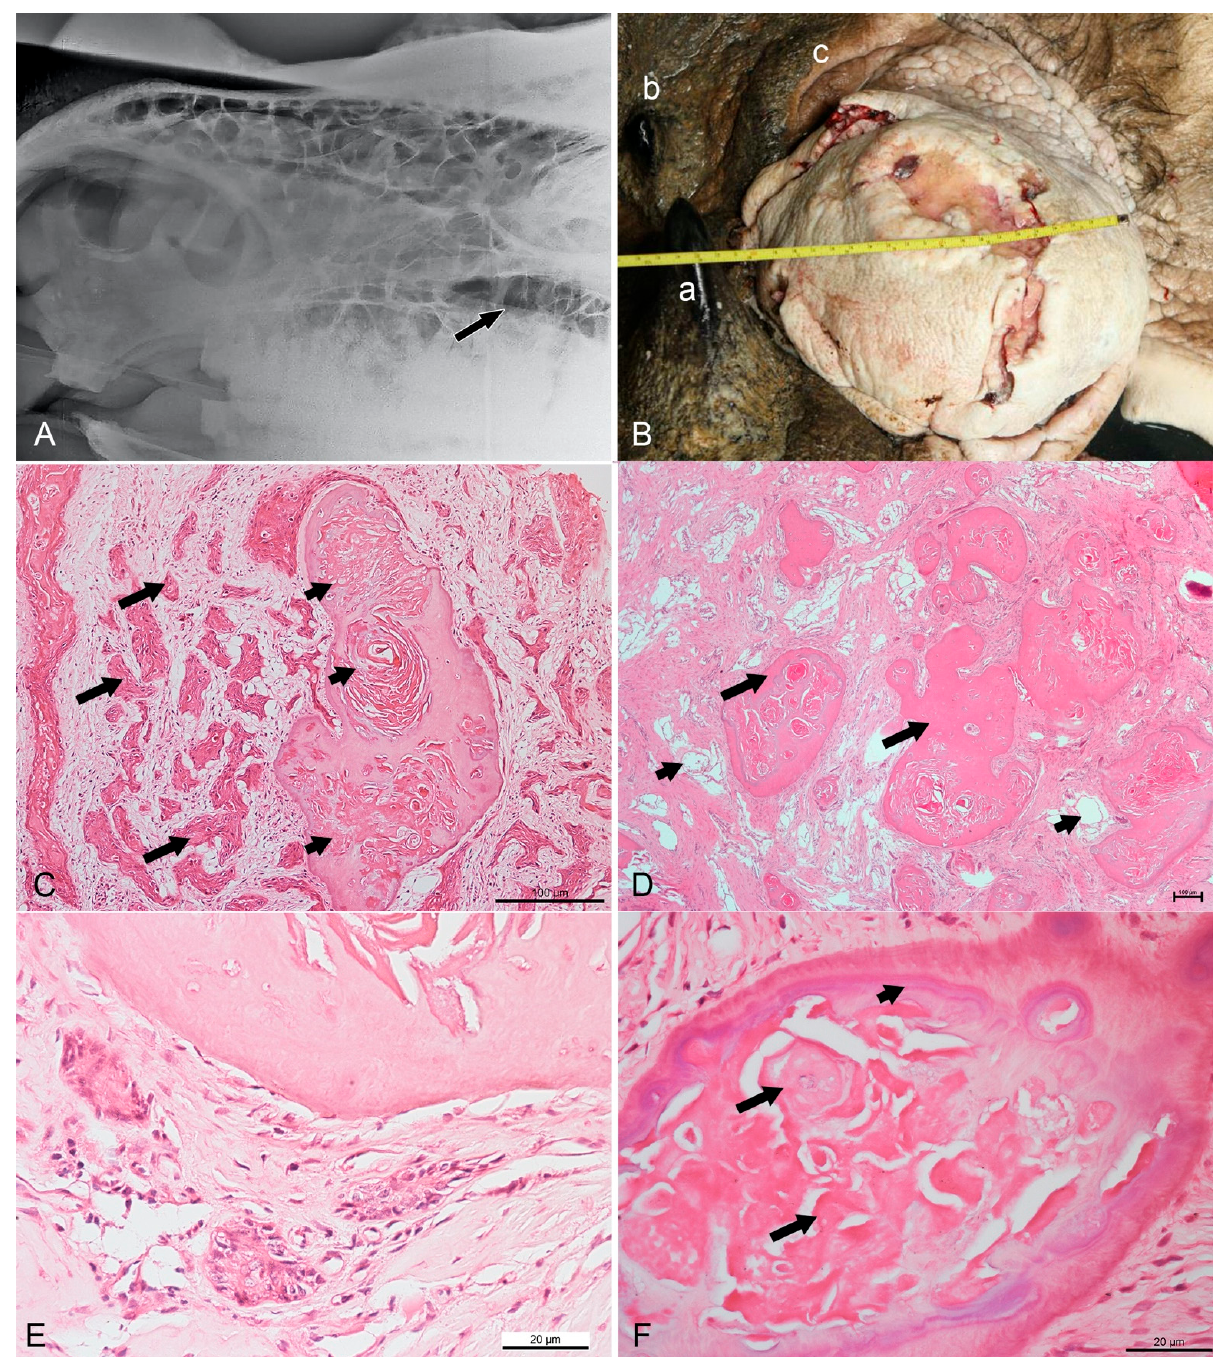
Figure 1. Radiographic, gross, and routine histopathological findings in a Sumatran rhinoceros with a dentinogenic ghost cell tumor. ( A ) Left-lateral view radiograph taken in April 2017 showing a unilocular radiolucent cyst (arrow) at the left maxilla. ( B ) The infraorbital mass in June 2017 measuring 21 cm × 30 cm. a: anterior horn, b: posterior horn, c: left upper eyelid. ( C ) Nests of neoplastic squamous cells (long arrows) surrounded by substantial compact fibrous stroma. Note the formation of keratin pearls (short arrows) embedded in a dentinoid material. HE (hematoxylin and eosin), bar = 100 µm. ( D ) Numerous islands of dentinoid material (long arrows) surrounded by loose and vascularized stroma (short arrows). HE, bar = 100 µm. ( E ) Neoplastic cells showing pleomorphism with basaloid- or stellate-reticulum-like appearance arranged in a nest. Vesicular nuclei can be observed. HE, bar = 20 µm ( F ) Ghost cell (long arrows) at the center of dentinoid material with cementum-like appearance (short arrow). HE, bar = 20 µm.